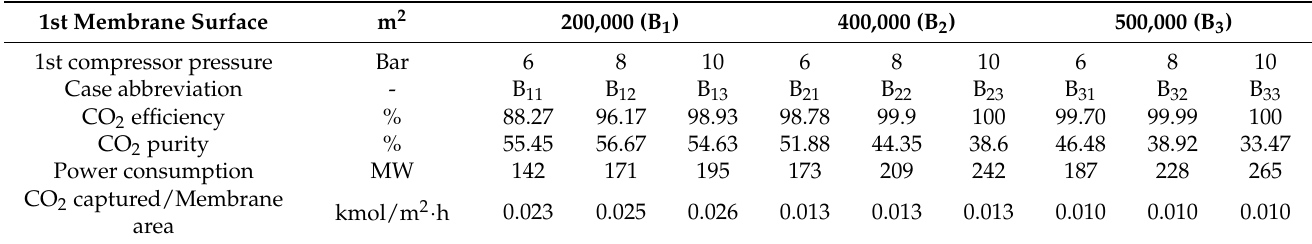
Table 12. The specific parameters were chosen for the technical and economical assessment of a single- stage of membrane technology (with a vacuum pump), case (B).